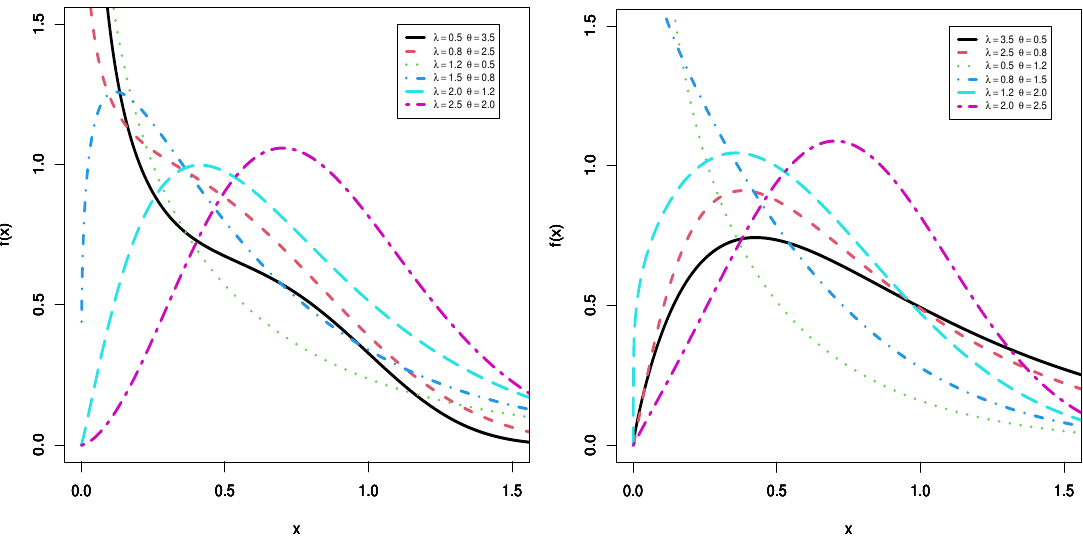
Figure 1. Plots of the pdf for TLMW model at α = β =